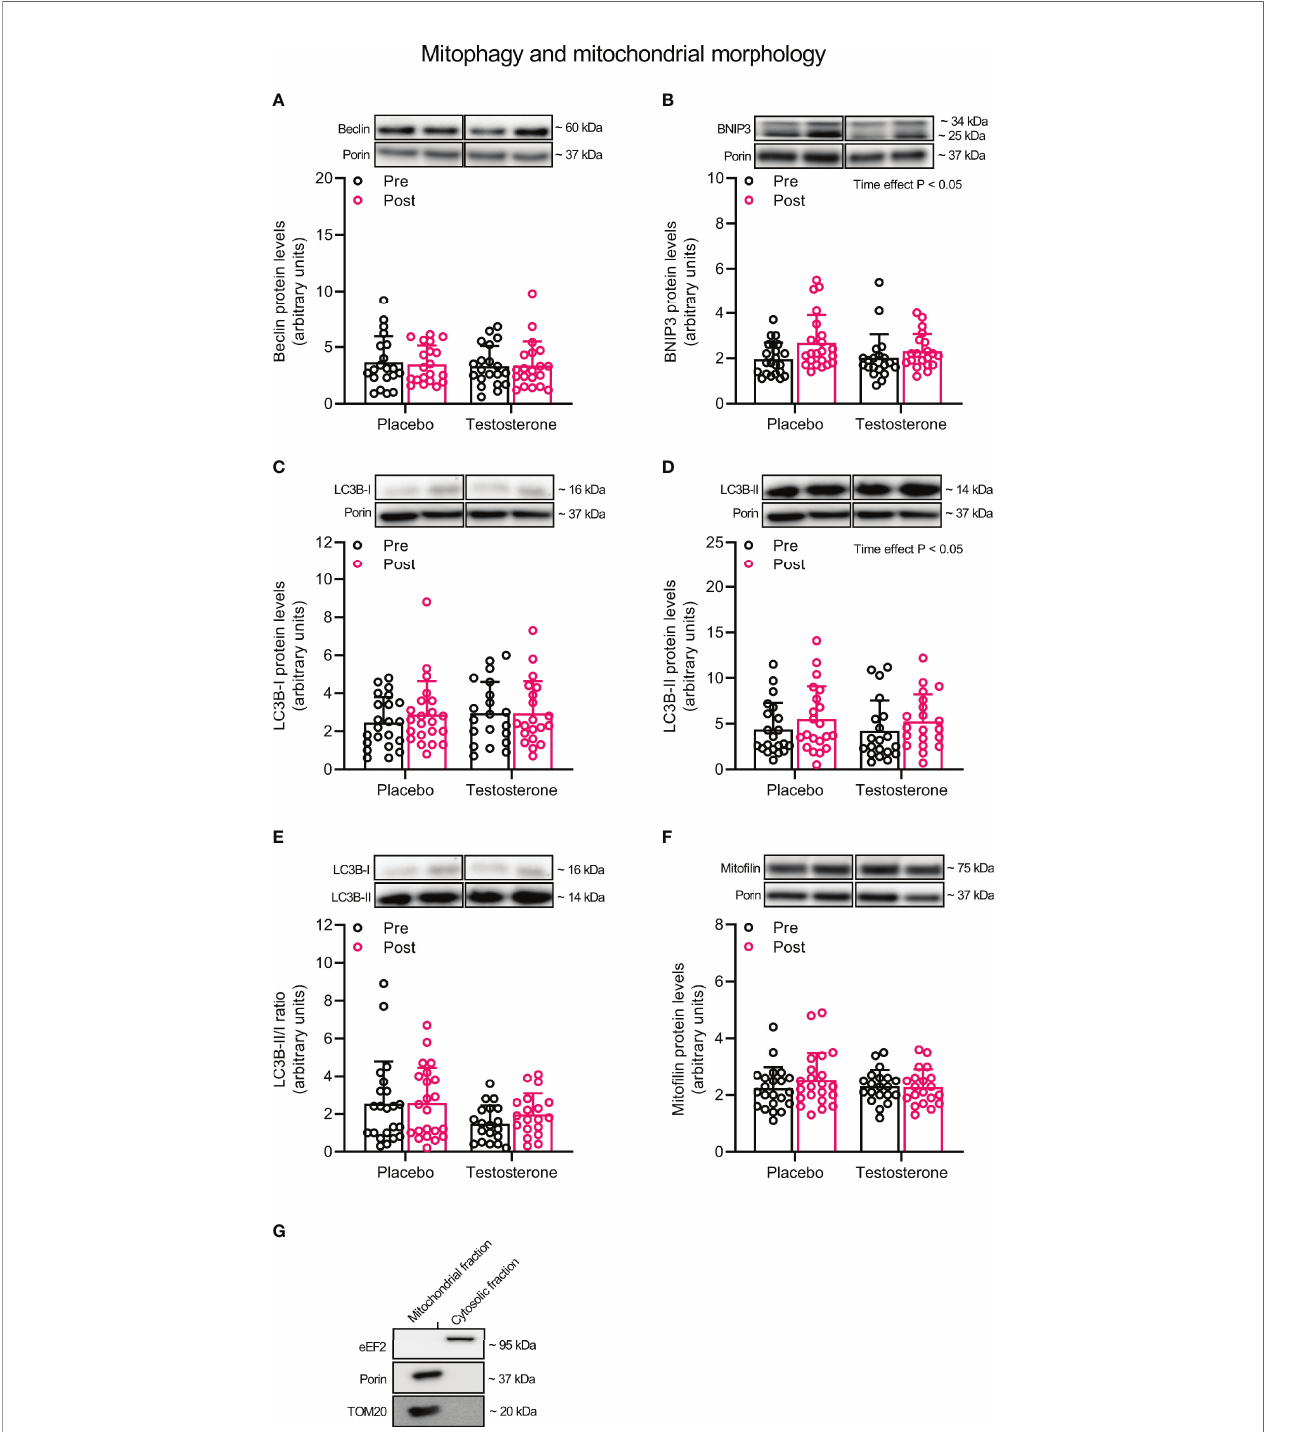
FIGURE 3 | Protein levels of Beclin (A) , BNIP3 (B) , LC3B-I (C) , LC3B-II (D) , LC3B-II/I ratio (E) and Mito fi lin (F) in the mitochondrial fraction before (black dots) and after the intervention (red dots), as well as the assessment of mitochondrial fraction purity (G) . Representative blots for each individual protein target and Porin are shown above each graph. The values presented are means ± SD and individual data points from 22 and 20 individuals (DF 40) in the placebo group and T group, respectively. The ANOVA revealed a signi fi cant main effect of time with respect to changes in protein levels for BNIP3 and LC3B-II. For illustrative purposes, two subjects from the placebo group displaying extreme values were removed from (A) (pre-post; 6.7 to 18.5 and 12.3 to 23.6, respectively) and one subject from the placebo group was removed from (D) (pre-post; 6.1 to 19.4), but these values were included in the statistical